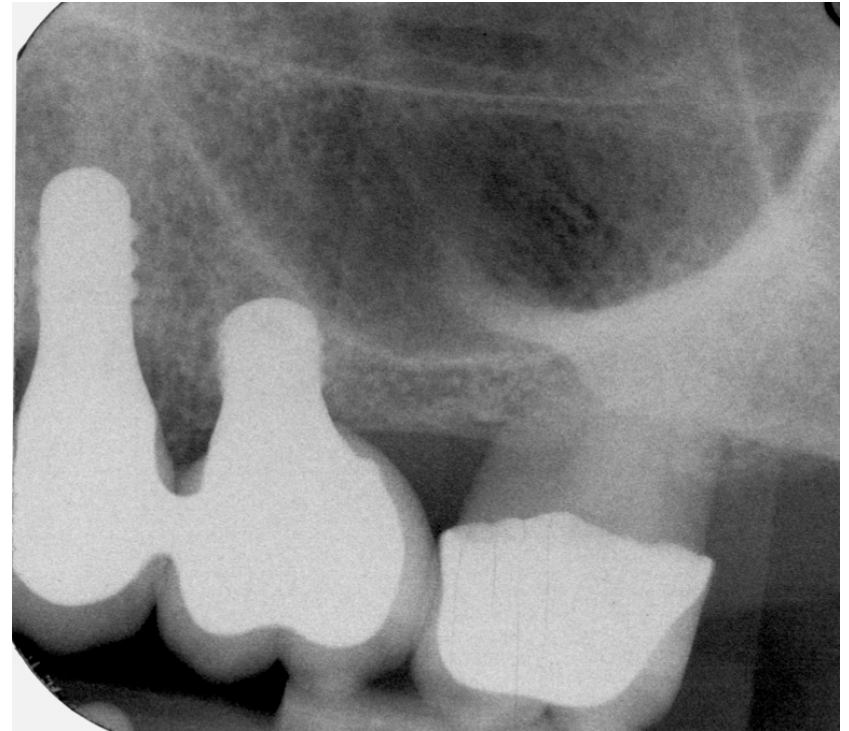
Figure 4. Radiograph of extra short and long implants at 12-month follow-up.